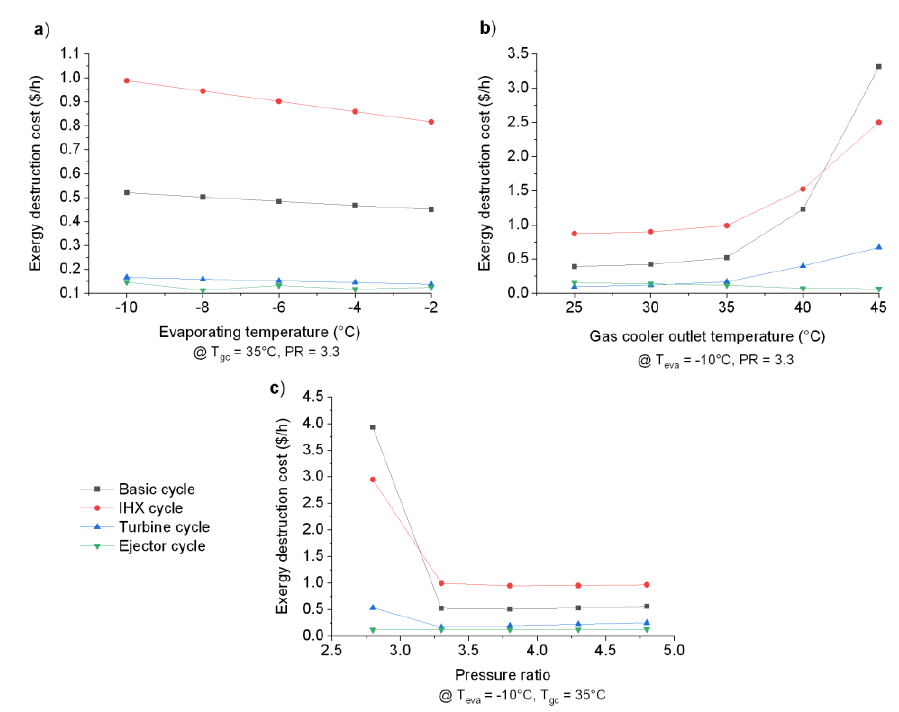
Figure 7. Variations in the exergy destruction cost due to the: ( a ) evaporating temperature; ( b ) gas cooler outlet temperature; ( c ) pressure ratio.